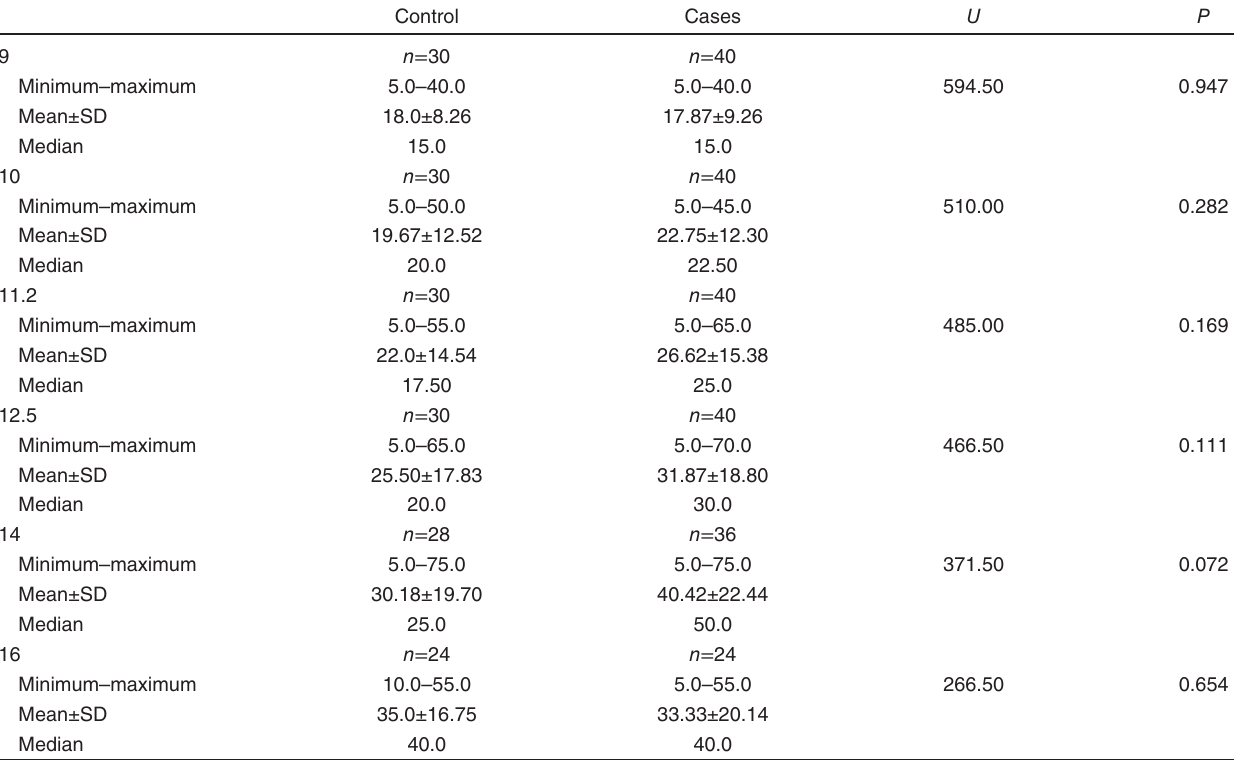
Table 3 High frequency audiometry thresholds in the two studied groups